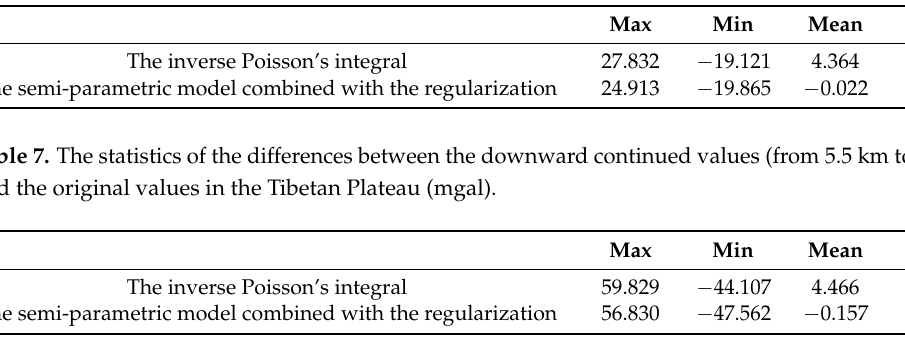
Table 6. The statistics of the differences between the downward continued values (from 11.5 km to 5.5 km) and the original values in the Tibetan Plateau (mgal).